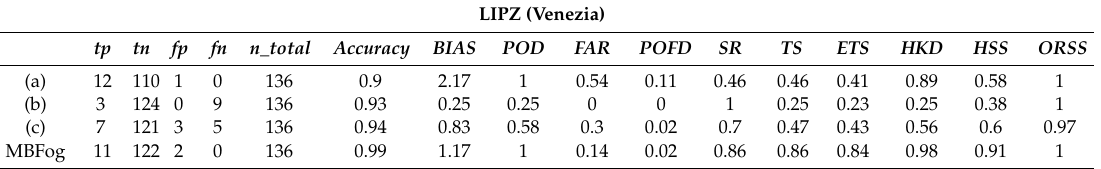
Table A5. Performances of several fog prediction methods for Venezia site LIPZ (Venezia)